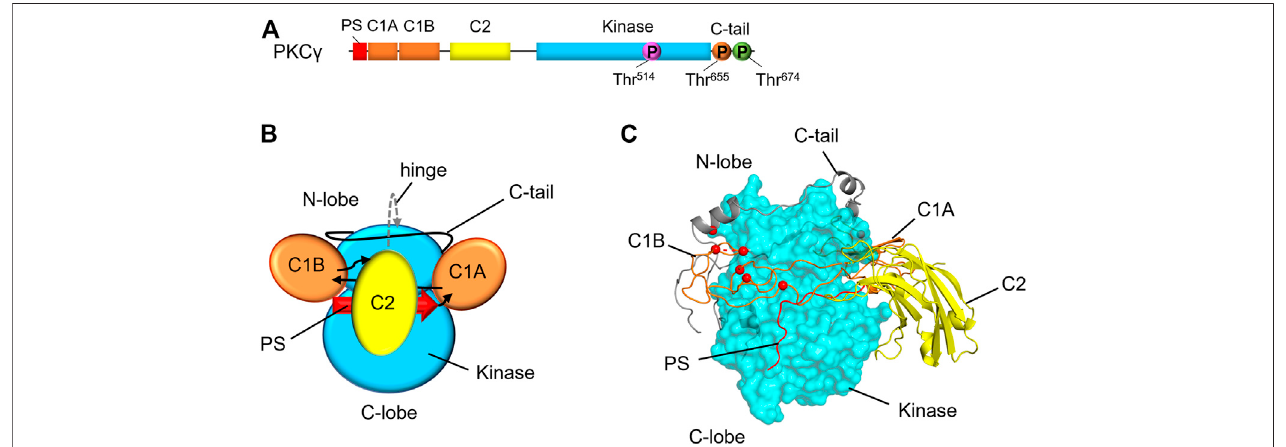
FIGURE1| DomaincompositionandstructuralmodelofPKC γ . (A) PrimarystructureofPKC γ ,includingthepseudosubstrate(PS,red),C1AandC1B(orange),C2 (yellow), kinase (cyan), and C-tail (black line). Circles indicate the priming phosphorylation sites: activation loop (pink), turn motif (orange) and hydrophobic motif